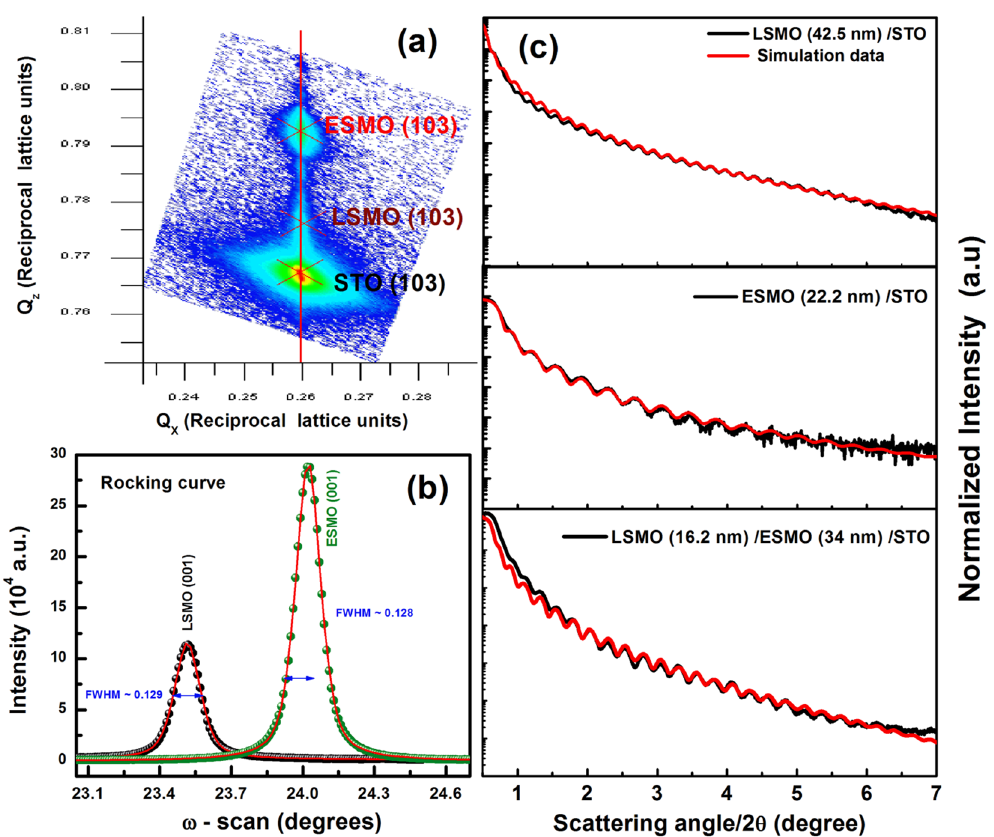
Figure 2. ( a ) Asymmetric RSM data along the (103) peak and ( b ) rocking curve for LSMO/ESMO bilayers and ( c ) XRR for the single LSMO and ESMO reference layers and